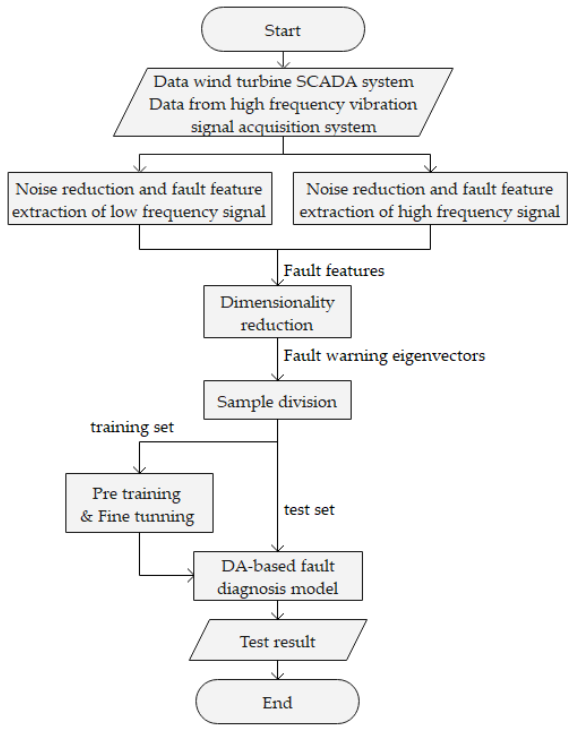
Figure 1. Flow chart of fault diagnosis approach of main drive chain in wind turbine based on data fusion.